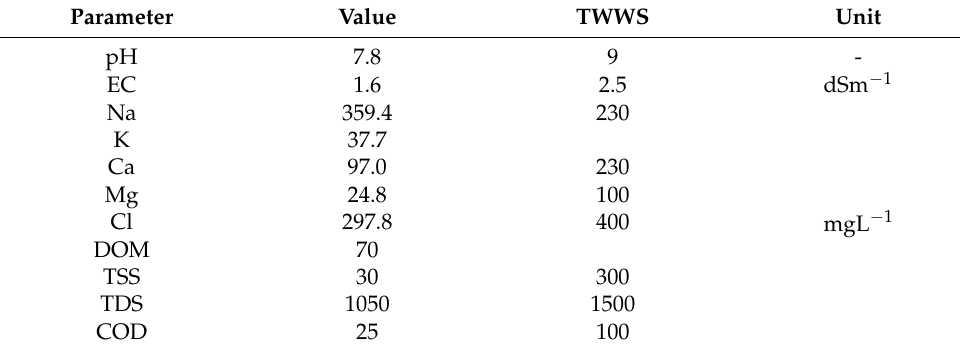
Table 1. Mean values of selected properties of the used TWW. Parameter Value TWWS Unit pH 7.8 9 - EC 1.6